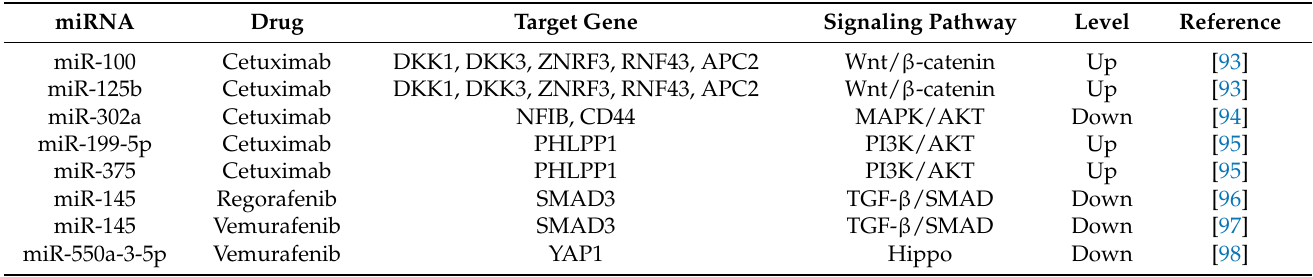
Table 2. MicroRNAs (miRNAs) involved in targeted drug resistance in colorectal cancer (CRC). miRNA Drug Target Gene Signaling